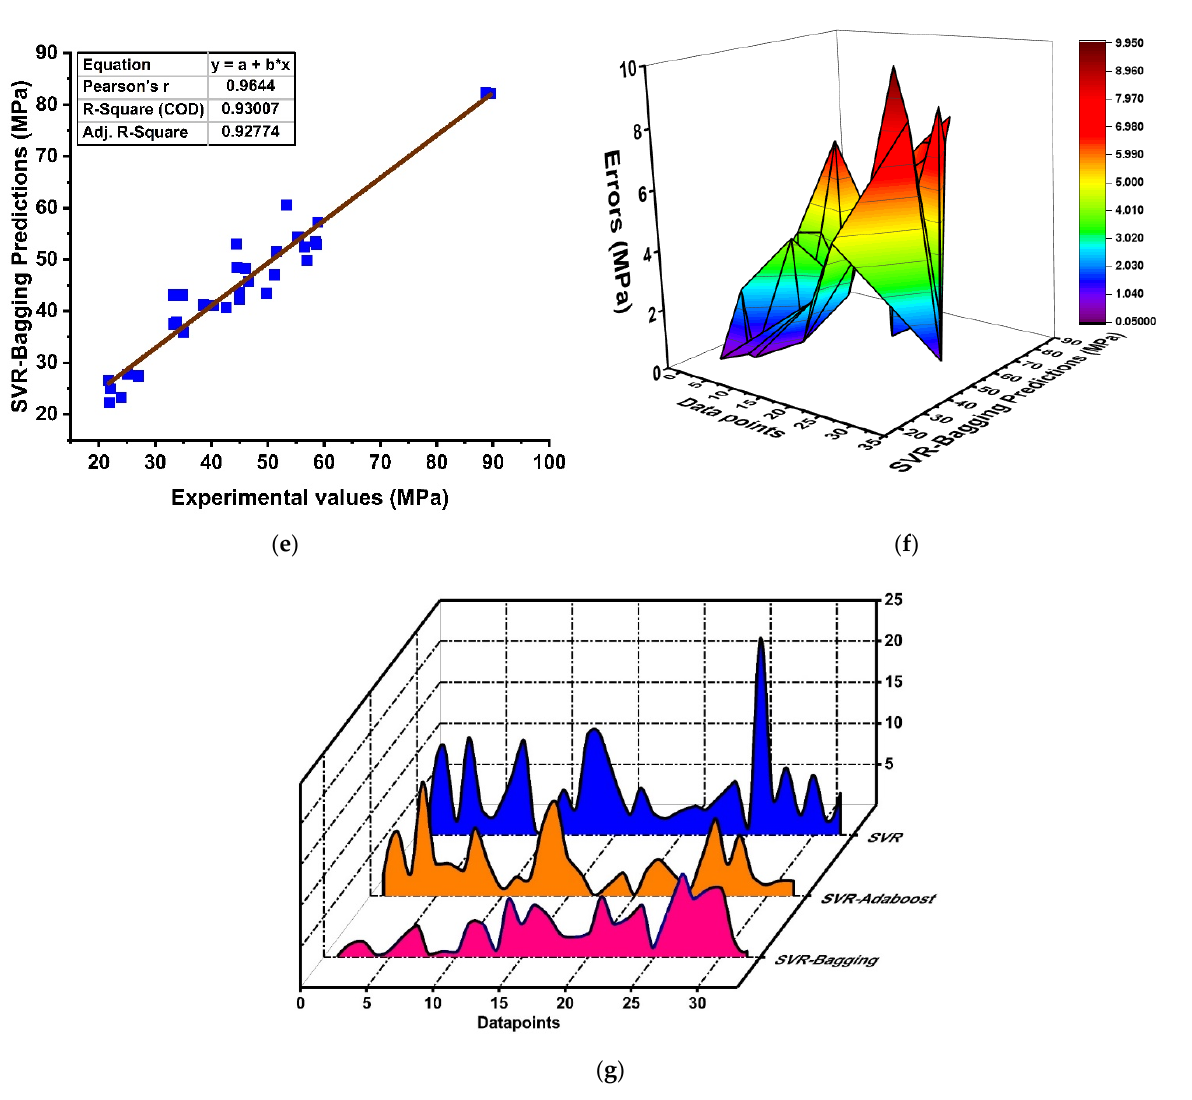
Figure 6. SVR modeling; ( a ) non-ensemble model; ( b ) non-ensemble absolute errors distribution; ( c ) ensemble model of SVR with boosting approach; ( d ) absolute errors of SVR with boosting approach; ( e ) ensemble model of SVR with bagging approach; ( f ) absolute errors of SVR with bagging approach; ( g ) Comparison of models with errors using waterfall plot.